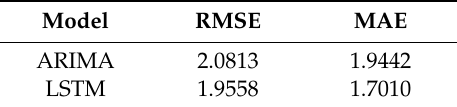
Table 3. Testing data for LSTM and